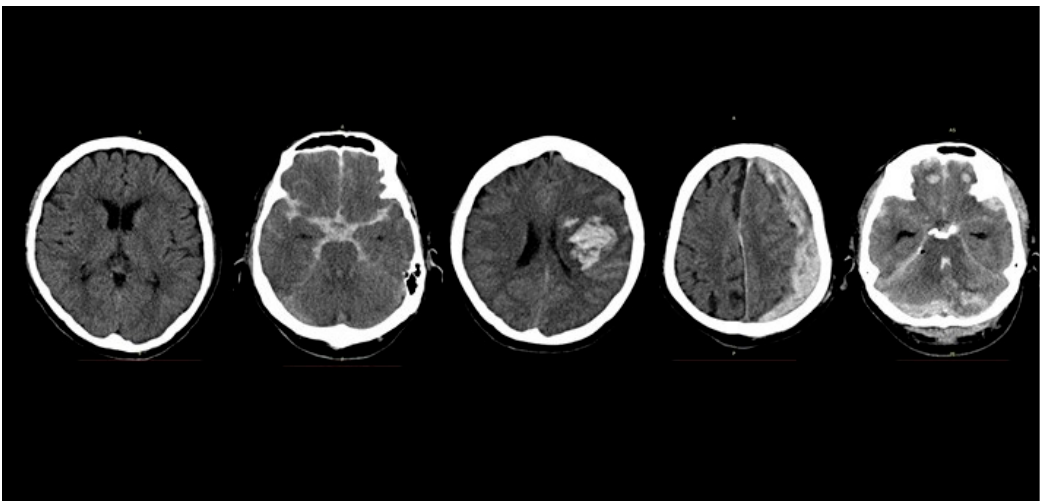
Figure 1. Computed tomography (CT) brain scans. From left, normal (N), subarachnoid hemorrhage (SAH), intraparenchymal hemorrhage (IPH), acute subdural hemorrhage (ASDH), brain polytrauma hemorrhage (BPH). Each image represents an individual image slice. One patient’s complete stack of CT images contained between 24 to 34 image slices in our dataset.